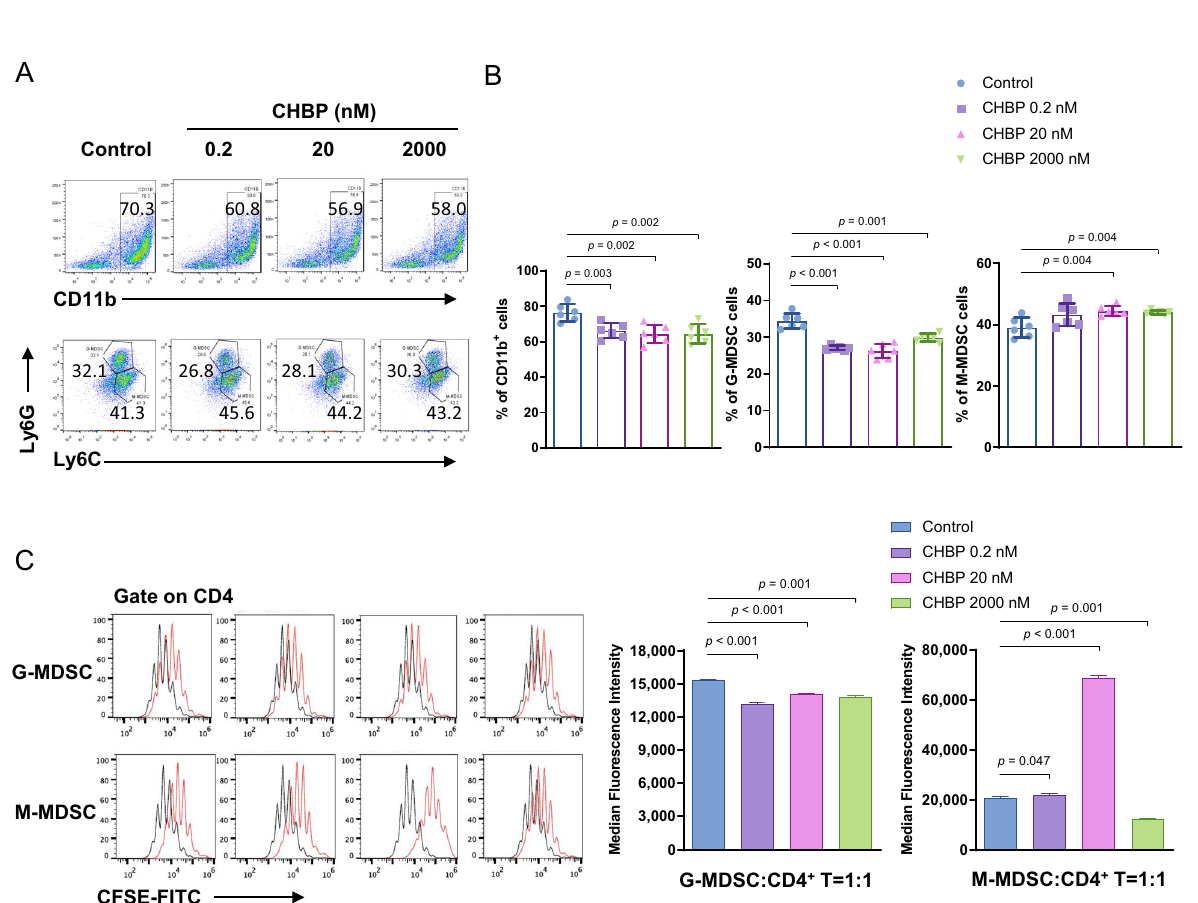
Fig. 1 CHBP induced M-MDSCs differentiation and enhanced M-MDSCs immunosuppressive function. A Detection of CD11b + myeloid cells, CD11b + Ly6G − Ly6C high M-MDSCs, and CD11b + Ly6G + Ly6C low G-MDSCs by fl ow cytometry. B Quanti fi cation analysis of CD11b + myeloid cells, M-MDSCs and G-MDSCs. C T-cell proliferation detected by CFSE. The ratio of G-MDSCs, M-MDSCs, and T cells was